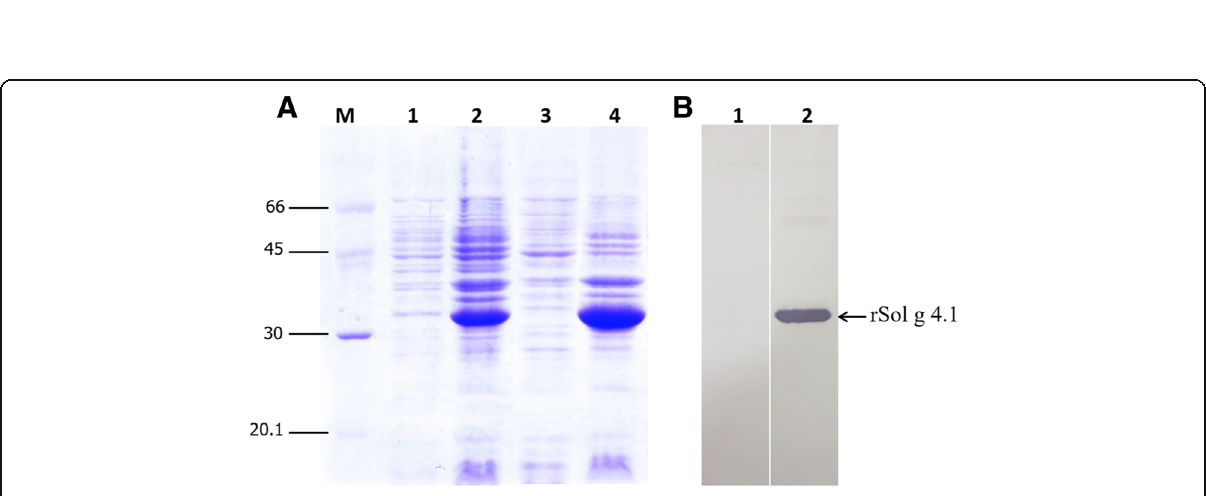
Fig. 3 Determination of the overexpression of rSol g 4.1 protein by SDS-PAGE and Western blotting. a Protein expression patterns in BL21(DE3) pLysS competent cells cultured under optimal conditions obtained using SDS-PAGE. Lanes: M – molecular weight standards; 1 – expression without IPTG; 2 – culture grown in the presence of 0.4 mM IPTG for 8 h.; 3 – cell extract in solution; 4 – cell extract in pellet. b Western blot of the rSol g 4.1 protein using an anti-His tag antibody; lane 1 – cells lacking the rSol g 4.1 protein and lane 2 – expression of the rSol g 4.1